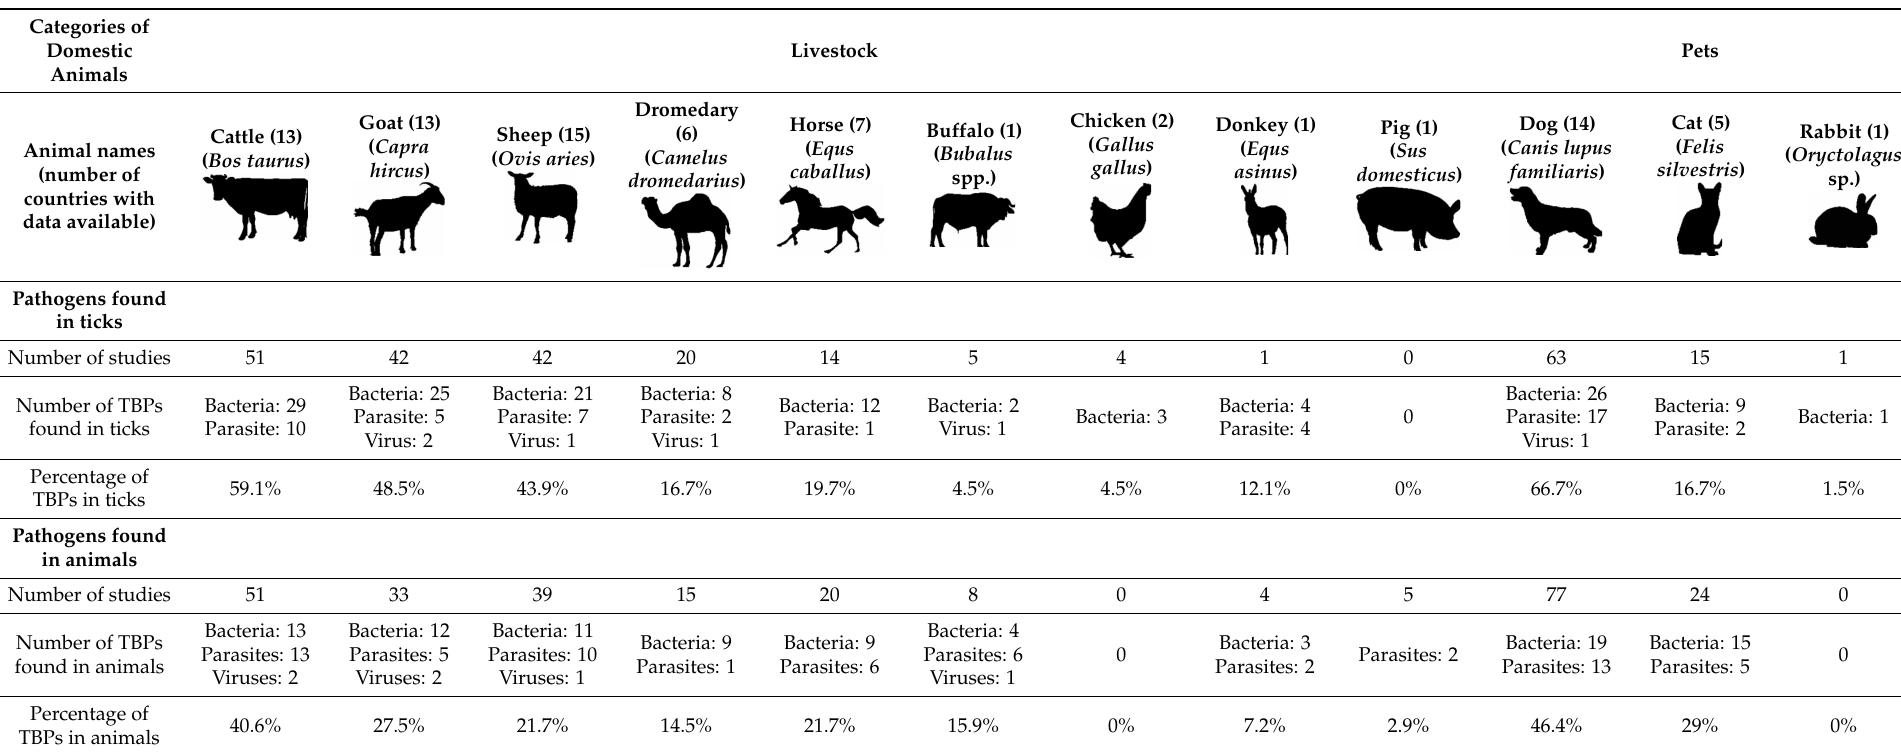
Table 2. TBP diversity in domestic animals or engorged ticks collected on these animals from the Mediterranean